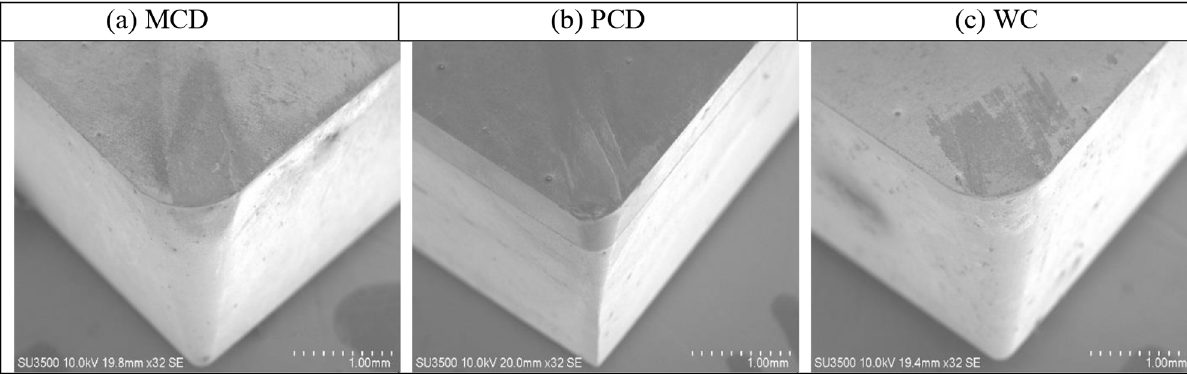
Fig. 19. SEM images of tool